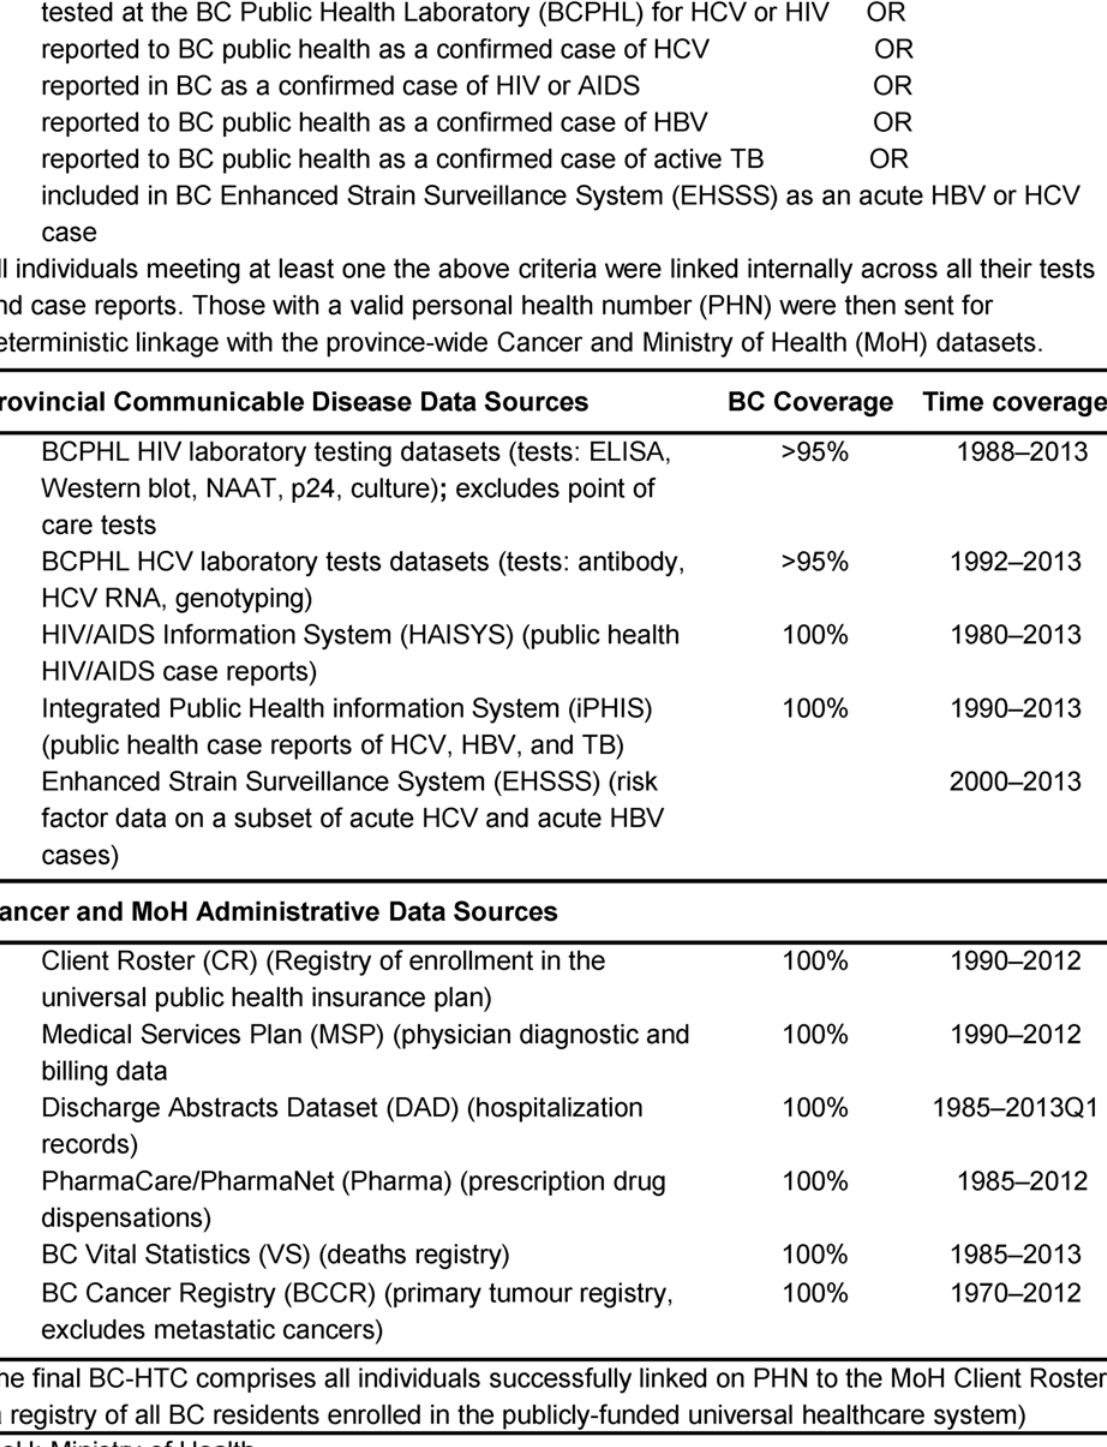
Fig 1. Criteria and Data Sources for the BC Hepatitis Testers Cohort (BC-HTC). doi:10.1371/journal.pone.0150176.g001 PLOS ONE | DOI:10.1371/journal.pone.0150176 March 8,